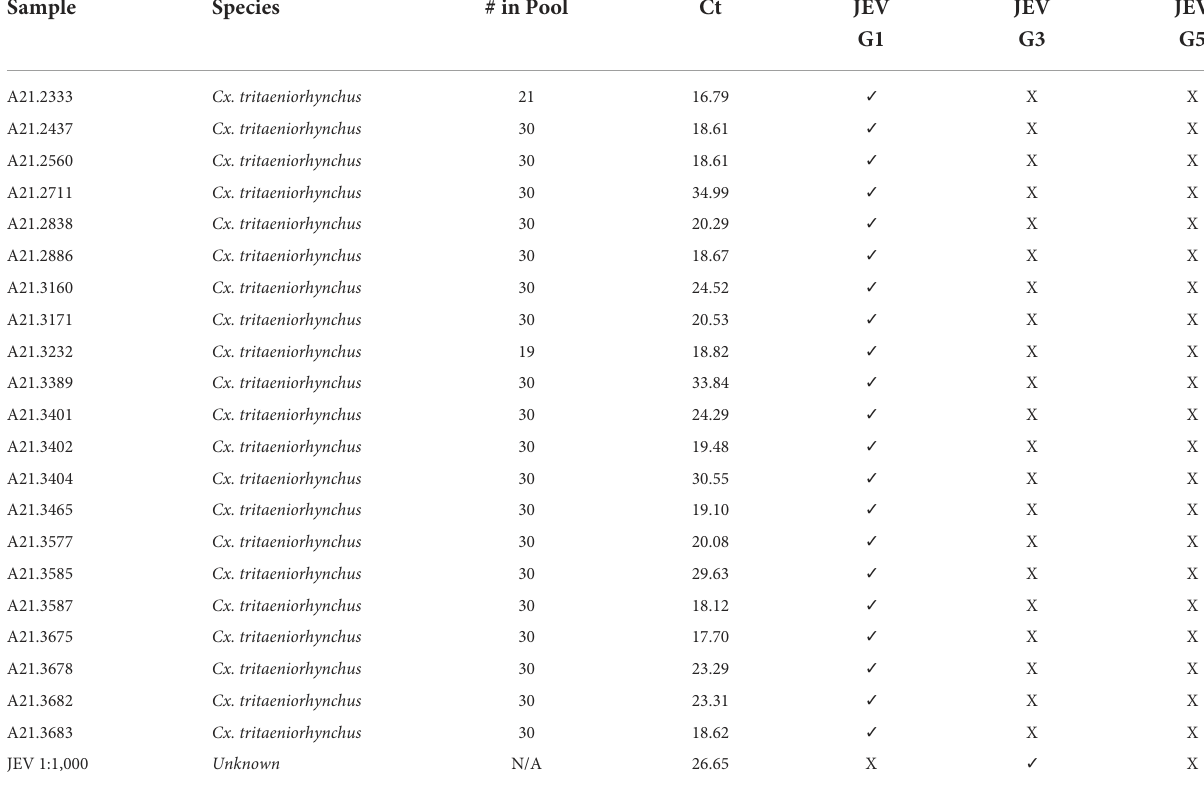
TABLE 2 JEV positive samples, “# in Pool” reflects how many mosquito specimens were in each sample pool tested, with their respective Ct values, and genotype.